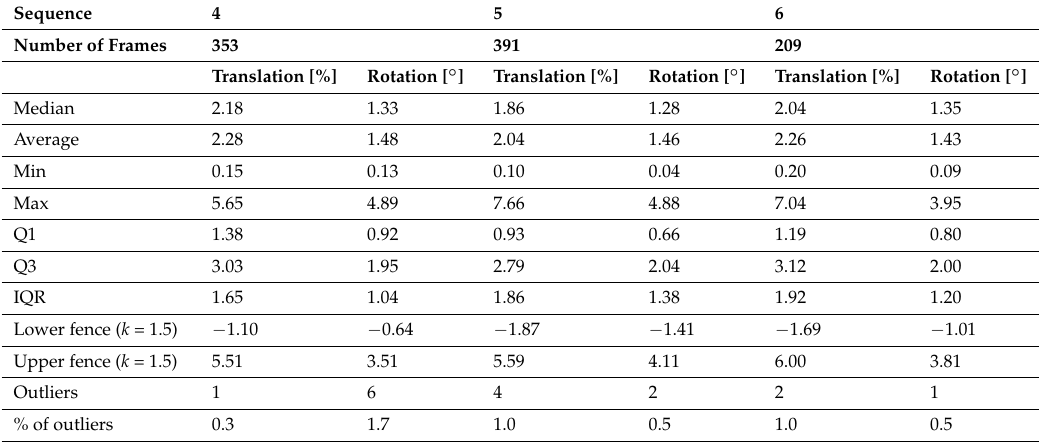
Figure 12. Algorithm evaluation of the King’s Chinese Cabinet. ( a ) Poster used to test the accuracy. ( b–d ) Camera poses in each sequence (red—ground truth; blue—our method). Table 3. Statistical accuracy evaluation of the three analyzed sequences of the Al Fresco Cabinet.